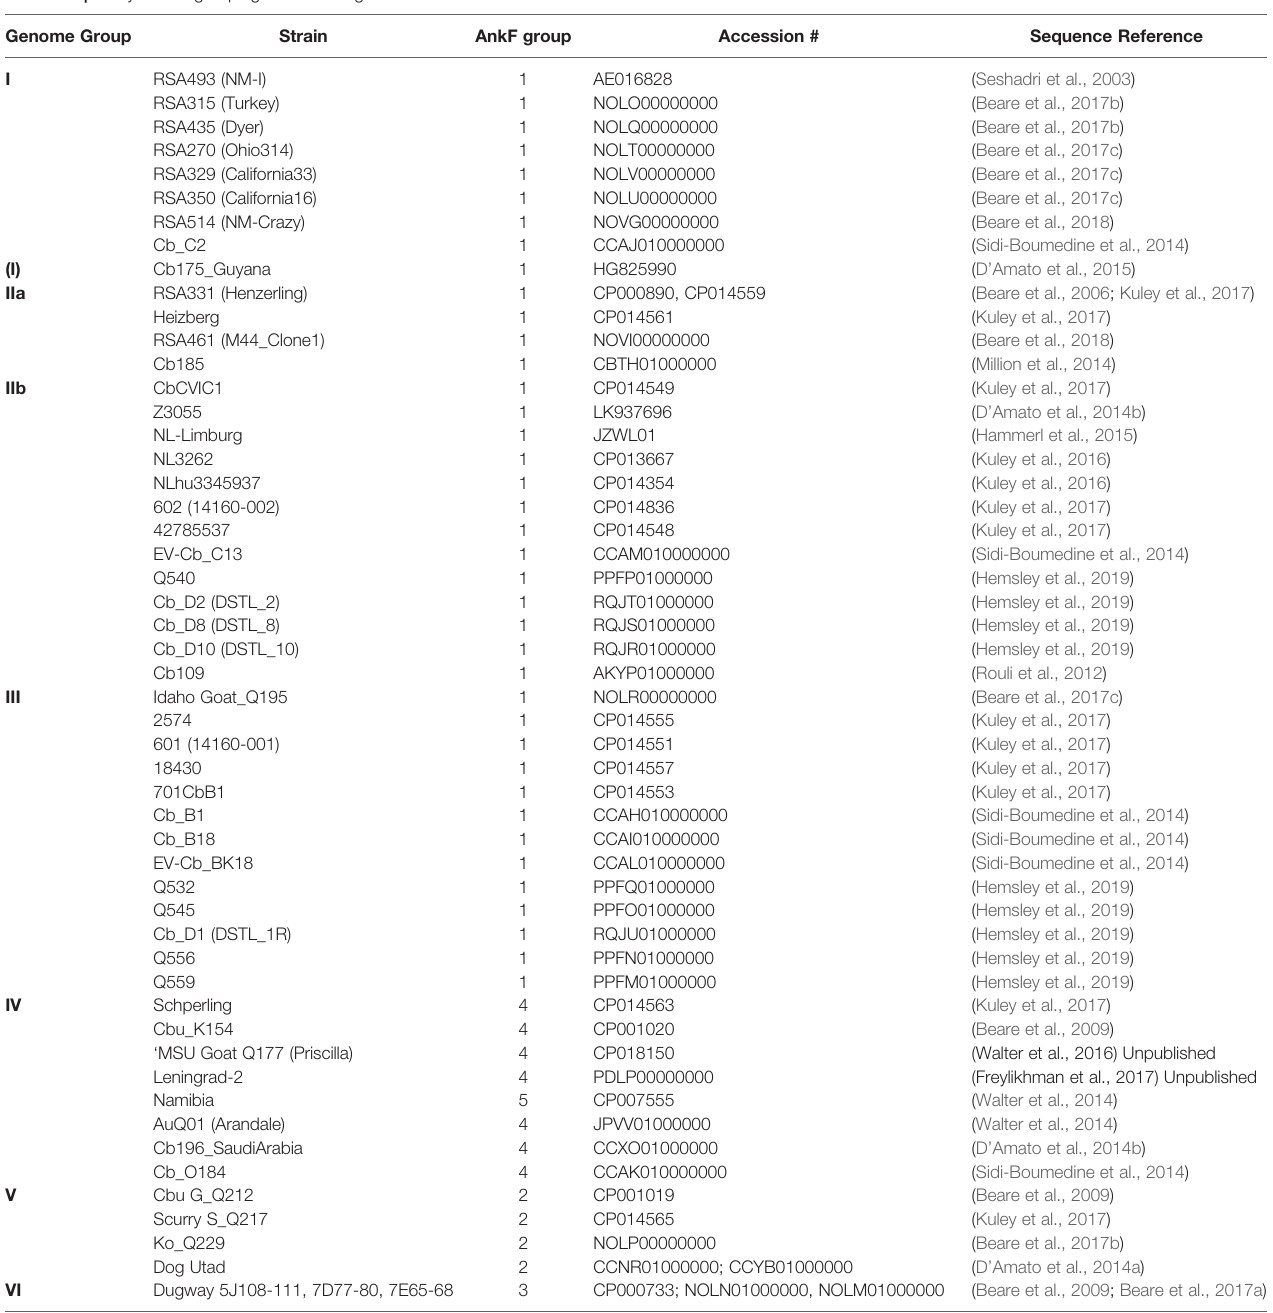
TABLE 3 | Analysis and grouping of the ankF gene in 52 C. burnetii